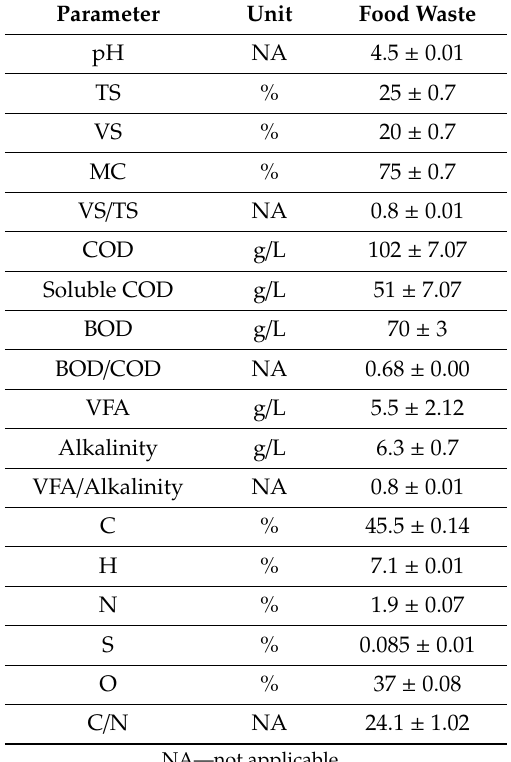
Table 2. Physicochemical characteristics of raw food waste.